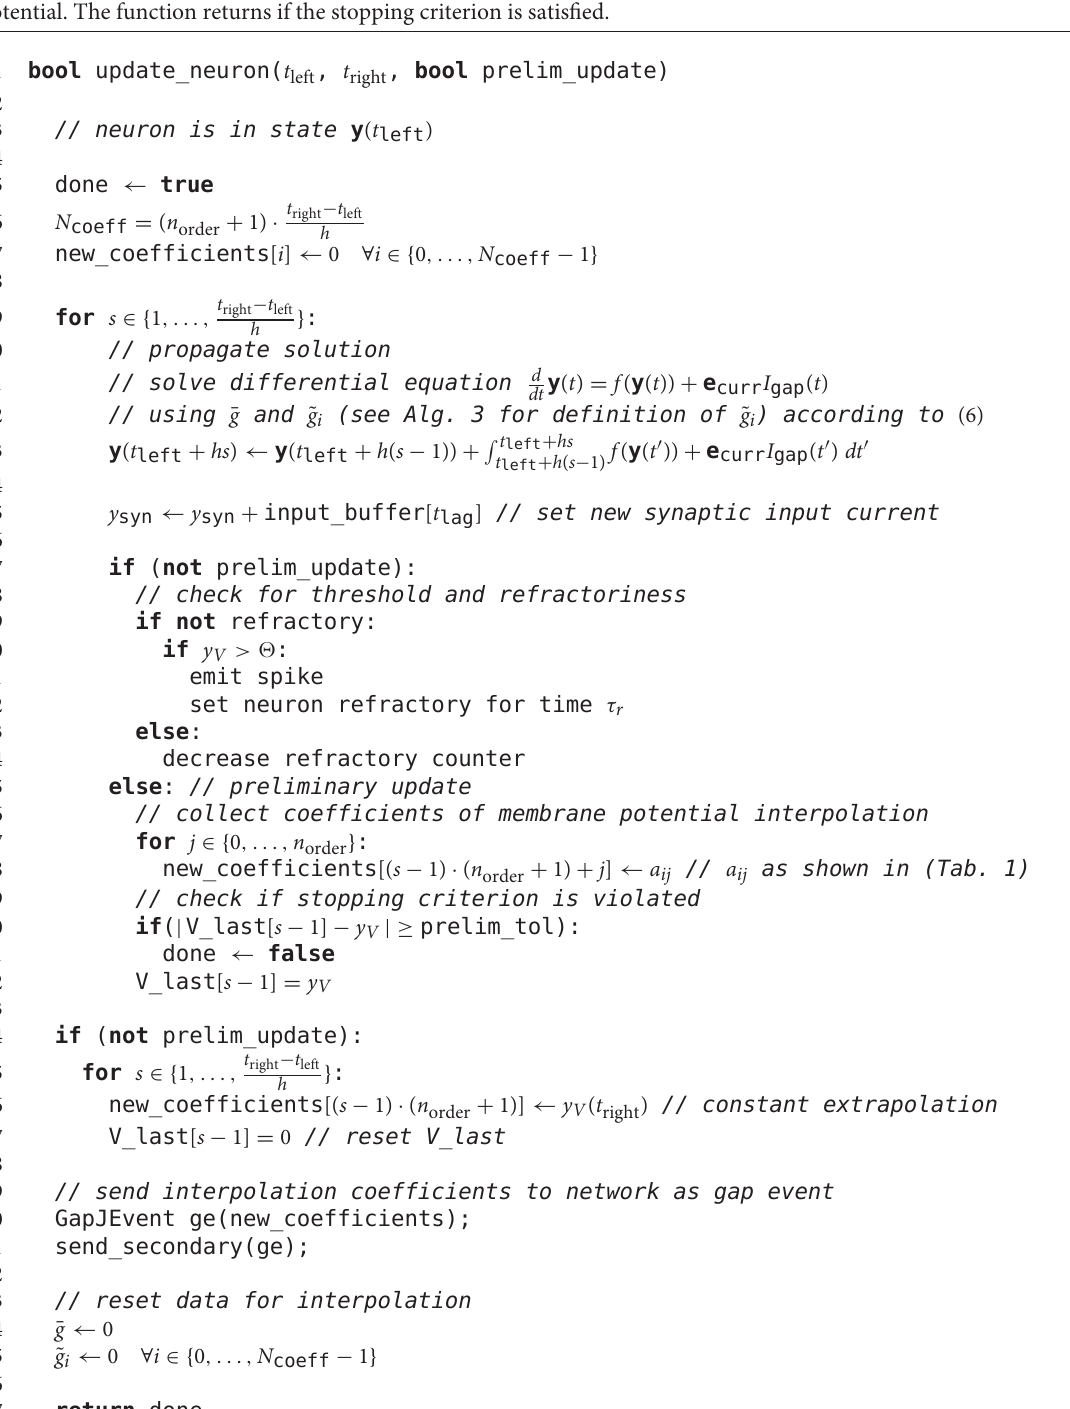
Algorithm 2 | Update function of a neuron model supporting gap junctions. The update function acts as a time-evolution operator and propagates the state of the neuron in time from t left to t right . The state of the neuron at time t is the vector y , where the component y curr represents the current flowing into the membrane and e curr is the corresponding unit vector for this component. The contribution t left + hs of the gap current e curr I gap ( t ′ ) dt ′ is given by Equation (6) and depends on the chosen method of approximation. The t left + h ( s − 1) integral sign symbolically represents the integrator for the differential system. The component y syn represents the component of the R synaptic input current, the initial condition of which is affected by incoming synaptic impulses in line 15 and y V denotes the membrane potential. The function returns if the stopping criterion is